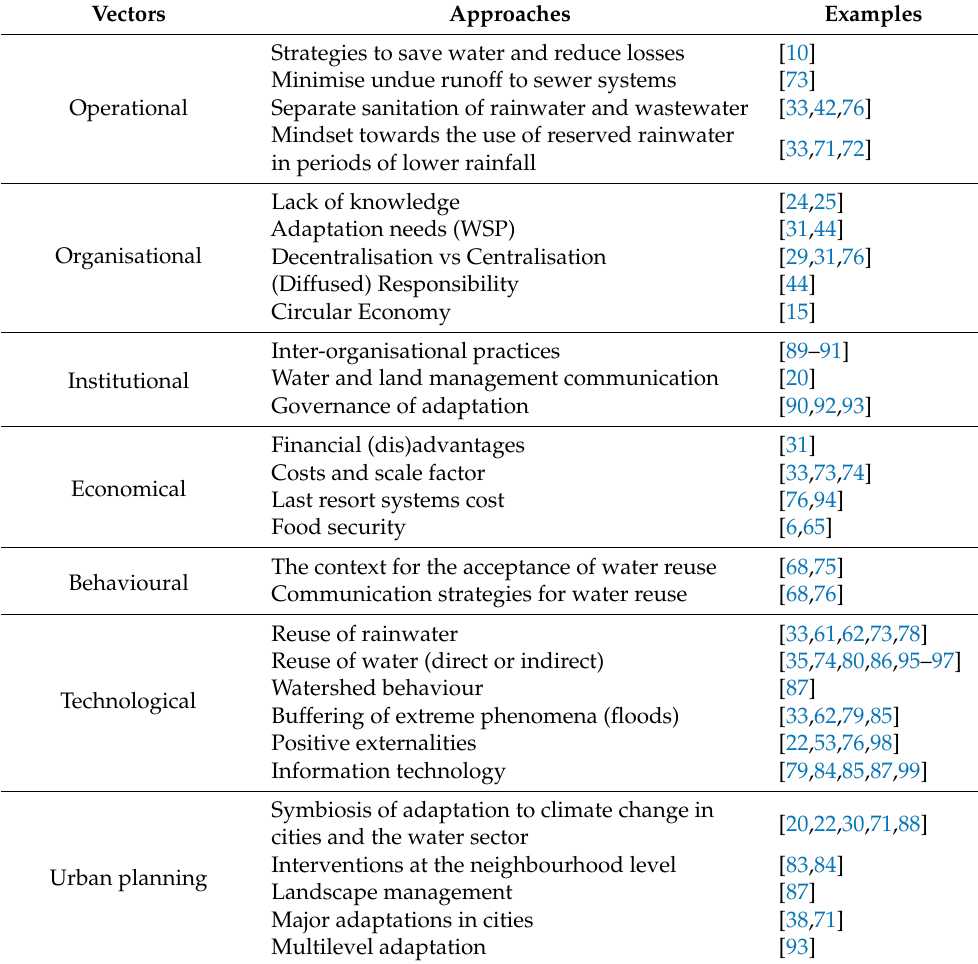
Table 4. Synthesis of the approaches to tackle climate change and urbanisation in the water sector.